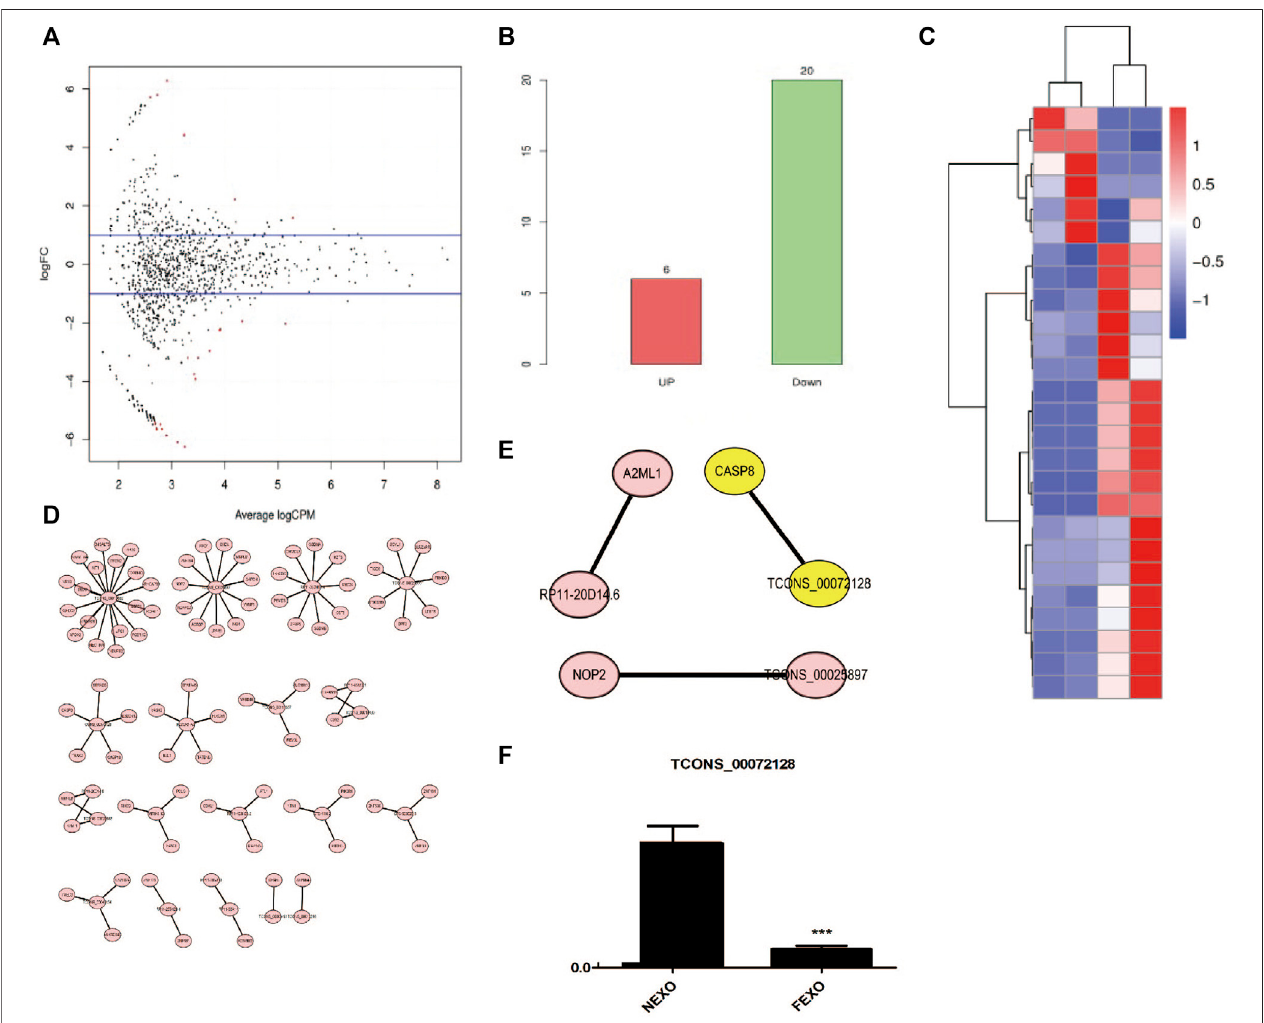
FIGURE3| AnalysisofdifferentiallyexpressedlncRNAsinexosomesfromhealthy(NC)andPMOPpatients(PP). (A) MAplotofdifferentialexpressionlncRNAs. (B) numbers ofdifferential expression lncRNAs. (C) Clustering ofdifferentially expressed genes.Hierarchical clustering based on FPKMs,where log10 (FPKM+1) is used for clustering. (D) cis-regulatory target genes of DE lncRNAs were shown. (E) Three pairs of potential lncRNAs and mRNAs interactions were both identi fi ed in the two methods. (F) RNA level of TCONS_00072128 in serum exosomes derived by healthy people and PMOP